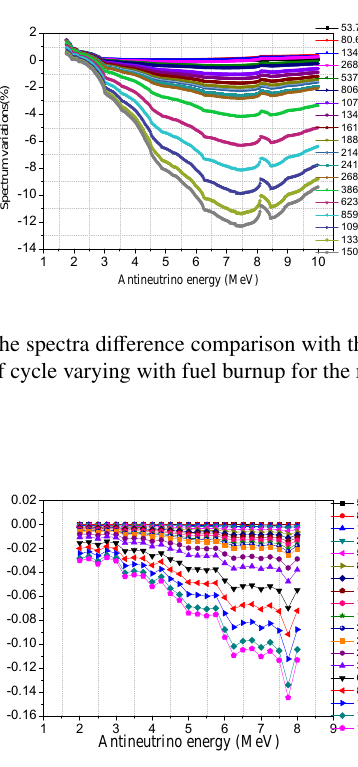
Figure 4. The spectra di ff erence comparison with the spectra of beginning of cycle varying with fuel burnup for the method-1 In ILL (Grenoble, France) experiment, the β spectrum of 235 U, 239 Pu, and 241 Pu were measured, and then the an- tineutrino spectrum were inferred from a beta spectrum with the assumption of 25 virtual beta spectrum[17–19].